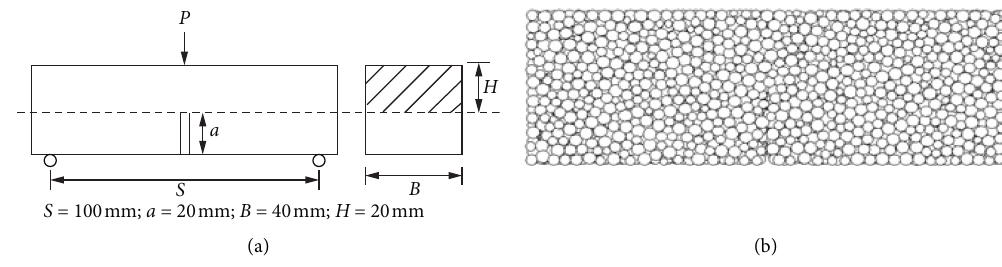
Figure 6: Three-point bending beam model. (a) Model size. (b) PFC 3D model.